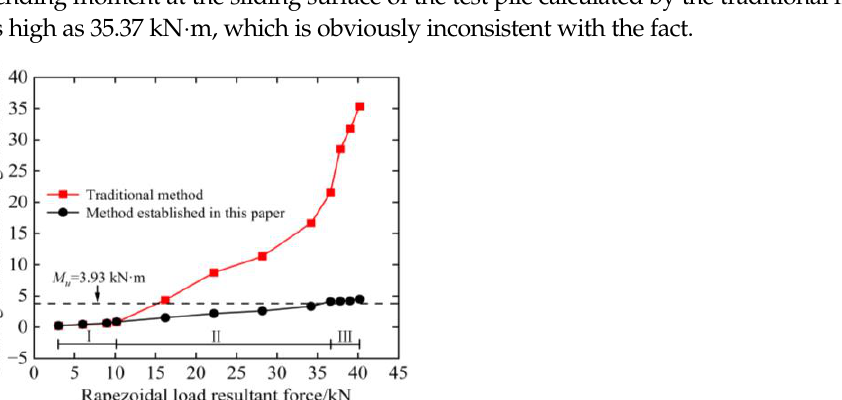
Figure 22. Three-dimensional numerical model and loading diagram of model pile.